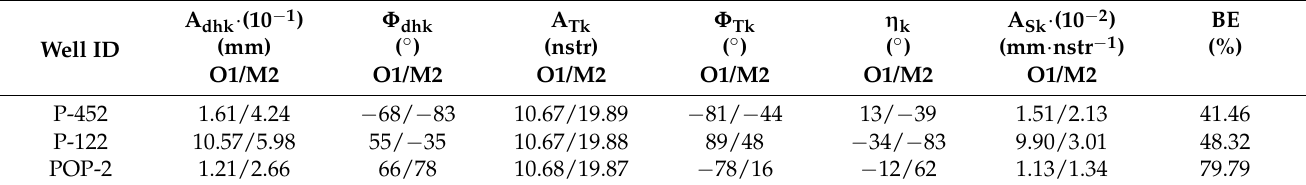
Table 3. Summary of results of the regression analysis, areal strain sensitivity, and barometric efficiency.